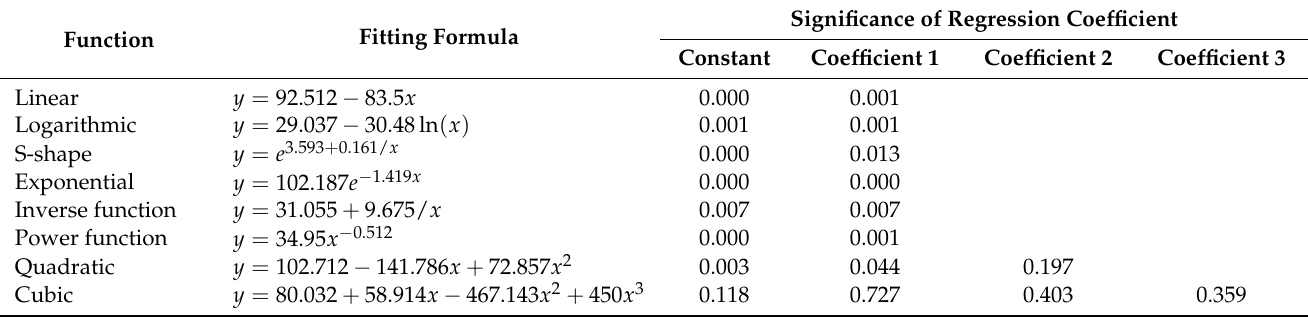
Table 4. Significance of regression coefficients t of the function.